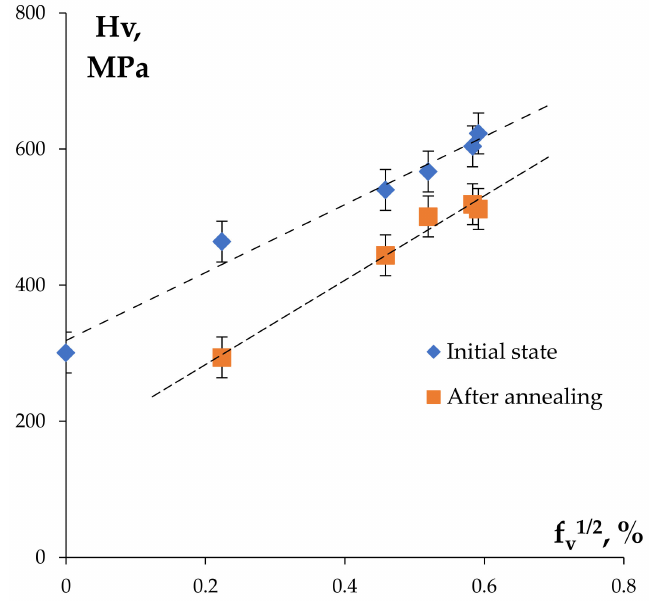
Figure 16. Dependencies of the microhardness of the Al wires H v on the volume fraction of the nucleated particles f v